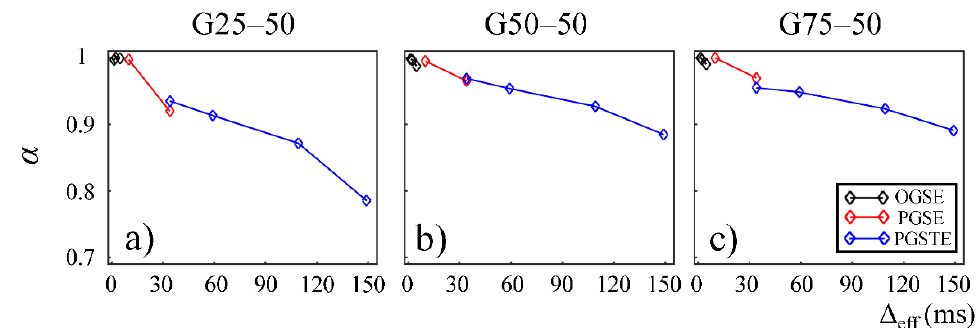
Figure 4. Plots of temporal fractional order ( α ) versus effective diffusion time, Δ eff , for gels G25 – 50 ( a ) and G50 – 50 ( b ), and G75 – 50 ( c ). The data acquired by using the OGSE, PGSE, and PGSTE pulse sequences are marked in black, red, and blue, respectively.